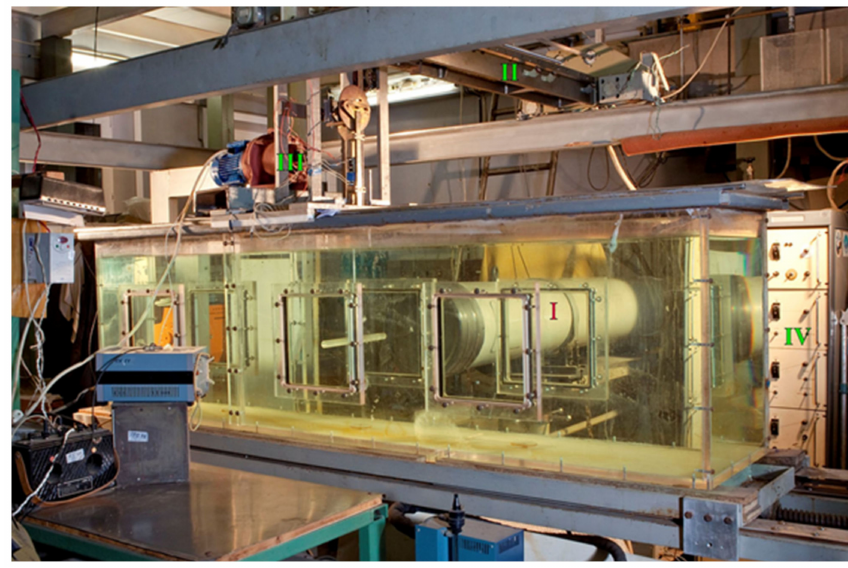
Figure 2. Experimental stand of the LMT USF “HPC IPMech